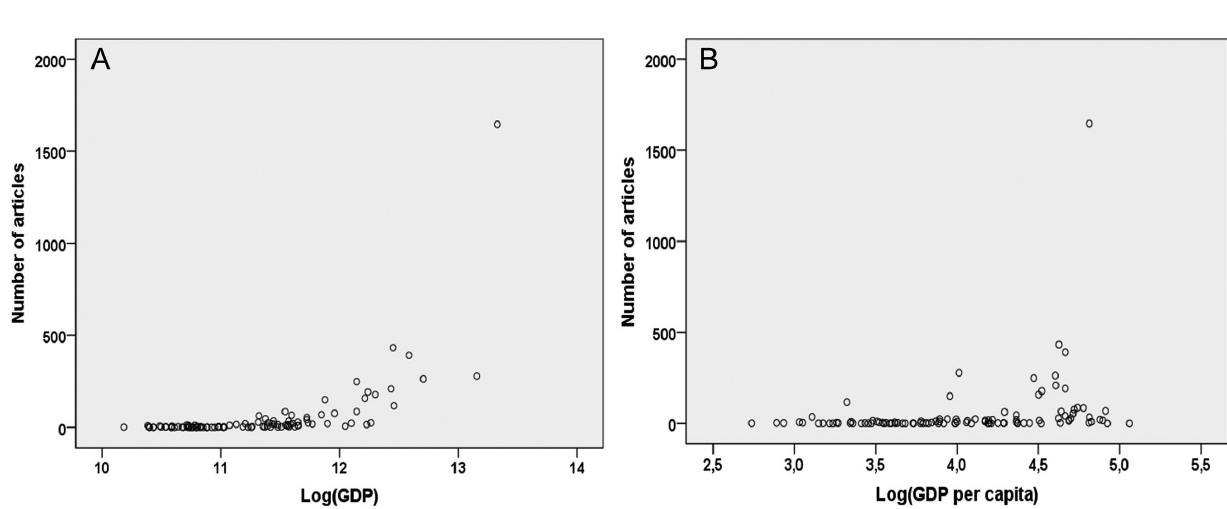
Figure 4. Scatterplot showing the relationships between the logarithms of countries’ gross domestic product (GDP), GDP per capita values, and their article